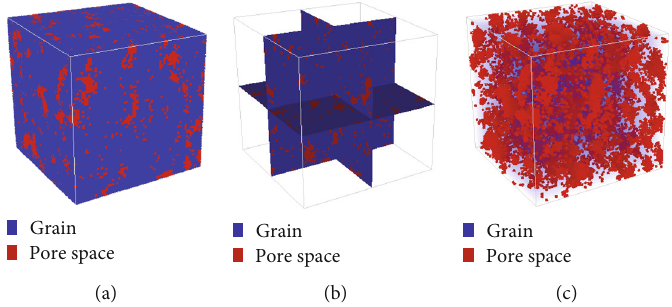
Figure 9: A reconstructed image using DS: (a) exterior; (b) cross-sections ( X = 32 , Y = 32 , and Z = 32 ); (c) pore space. Table 1: Porosities of the TI and the reconstructed images (shown in Figures 6 – 9) using IVAE, SNESIM, VAE, and DS.